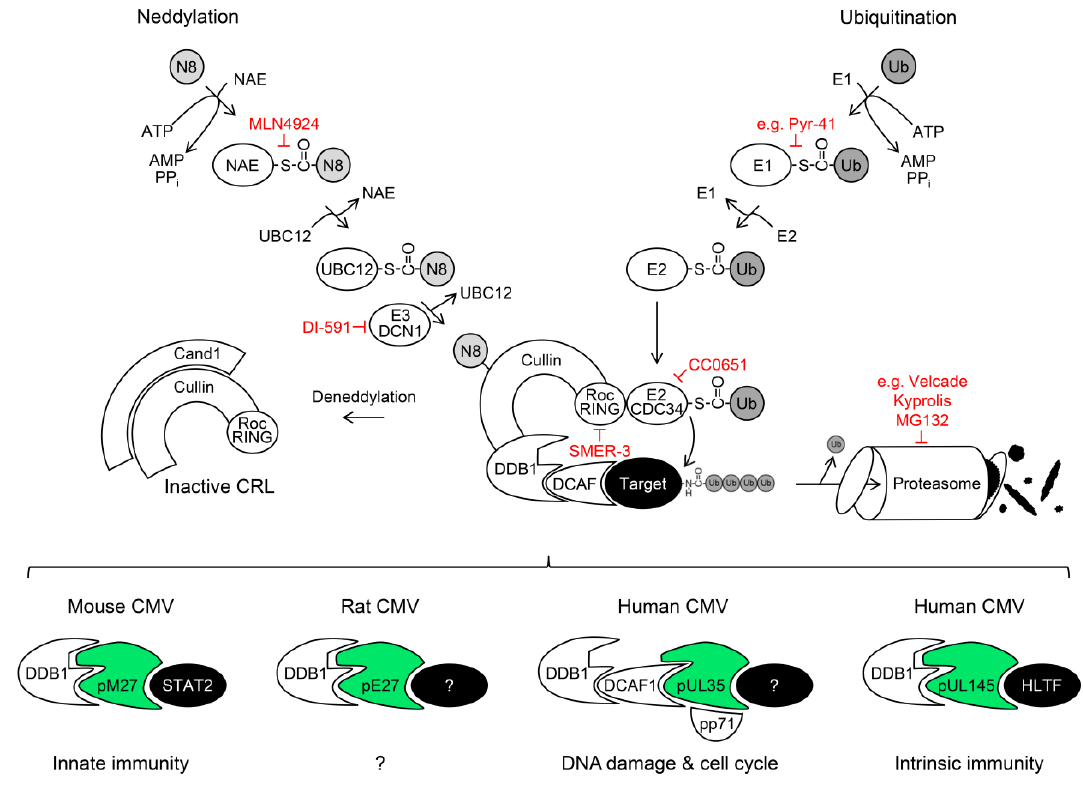
Figure 1. Exploitation of cellular cullin (Cul) RING ubiquitin (Ub) ligases (CRLs) by cytomegaloviruses. Simplified model of neddylation (left part), ubiquitination (right part), CRLs (central parts), and their exploitation by cytomegaloviral proteins (lower part). Drugs inhibiting the ubiquitin-proteasome system (UPS) or CRLs are highlighted in red. Please see the text for details and abbreviations.